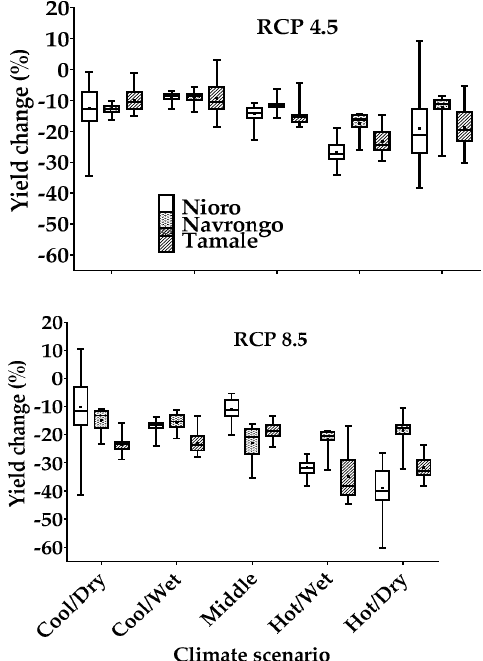
Figure 3. Simulated future maize yield changes under di ff erent climate scenarios for the Nioro, Senegal, Navrongo and Tamale Ghana sites. (Note that for a given scenario, GCMs are not necessarily the same). Each box in the graph shows the distribution of relative yield change across farms. The boundary of the box closest to zero indicates the 25th percentile, a line within the box marks the median, the dots depict the means, and the upper boundary of the box indicates the 75th percentile. Whiskers above and below the box indicate the 95th and 5th percentiles.